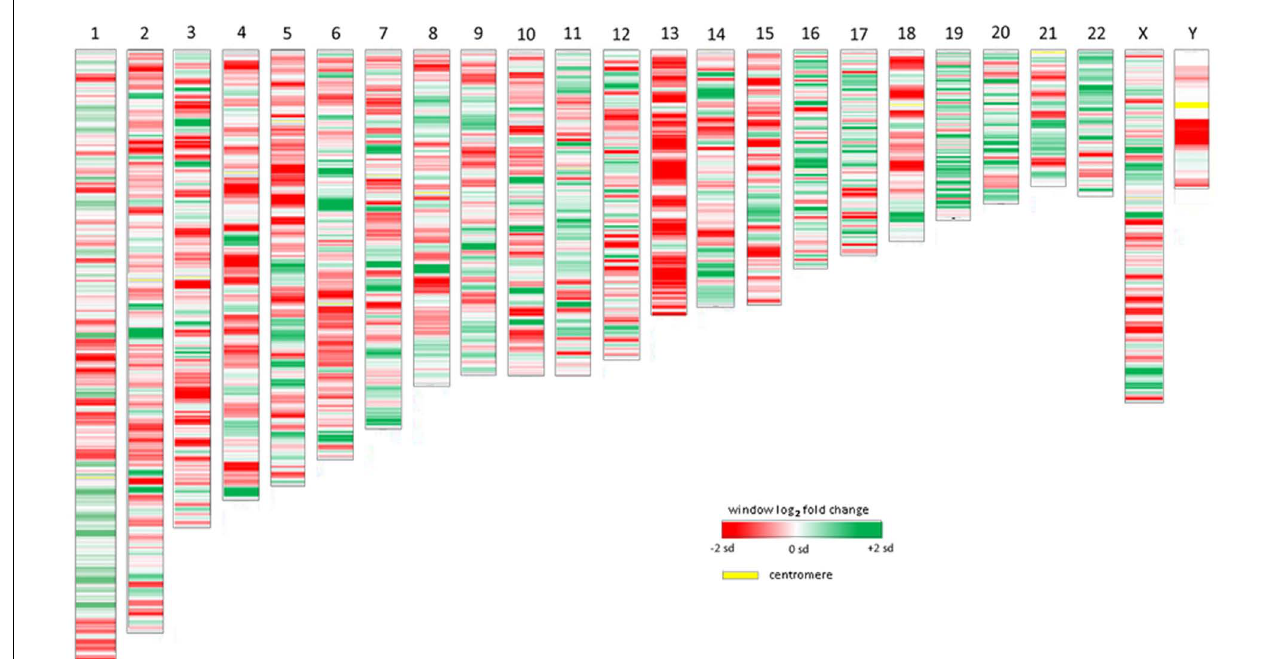
FIGURE 2 | Heat map demonstrations of long linear chromosomal differential transcription of A. phagocytophilum -infected human neutrophils vs. uninfected neutrophils. The human chromosome number is shown at the top. The colors represent